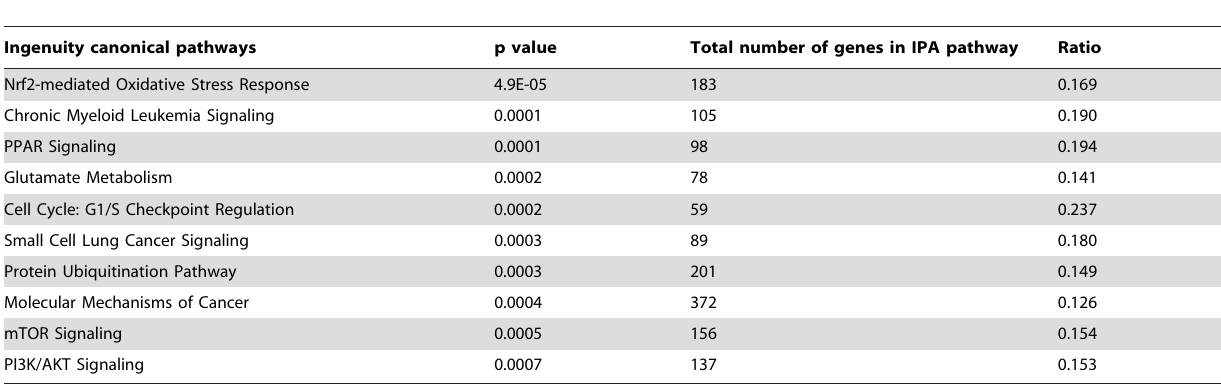
Table 4. Top IPA pathways enriched with genes showing dose-responsive changes after SWT treatment and corresponding Fisher’s exact test p values.